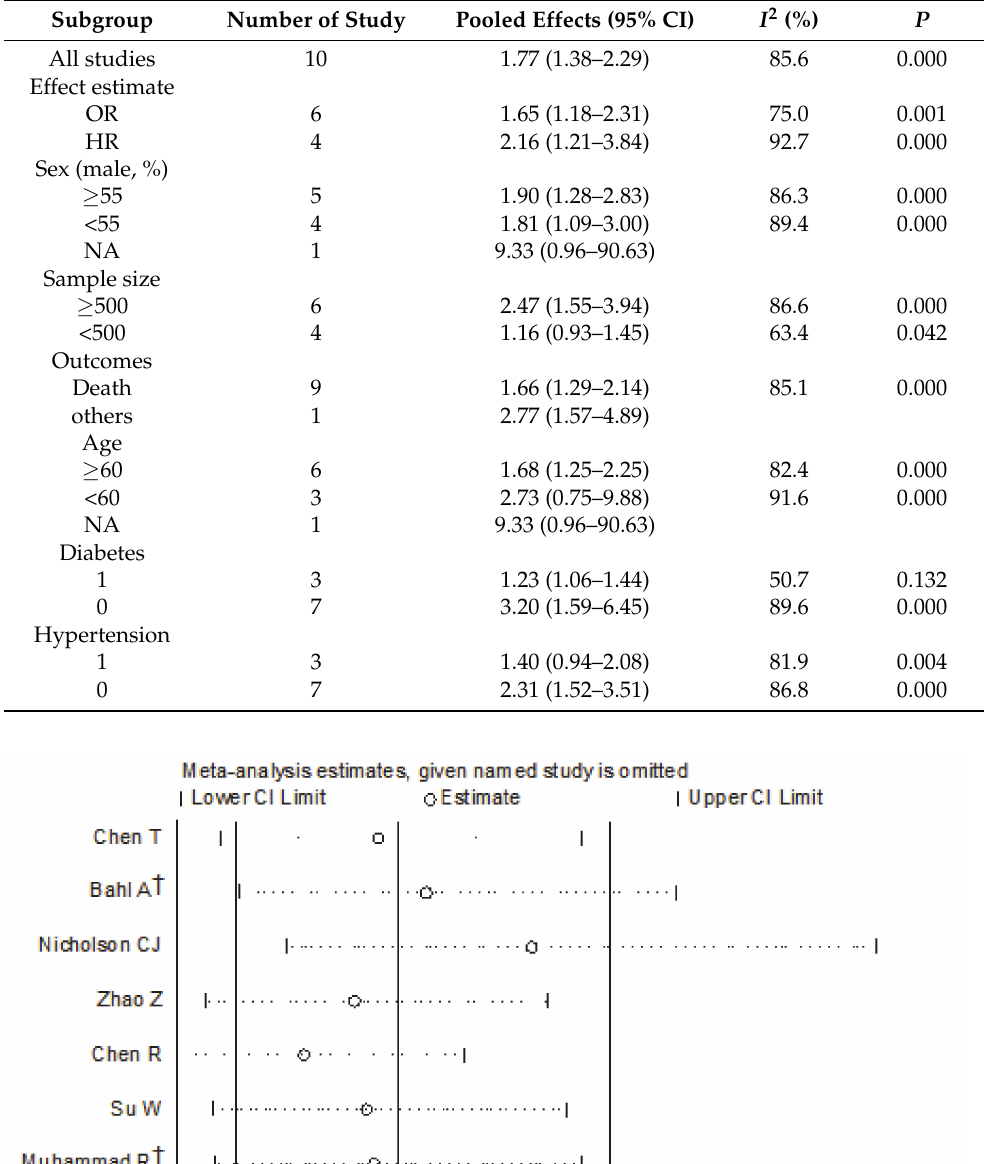
Table 2. Subgroup analysis on the association between PCT and the severity of COVID-19.